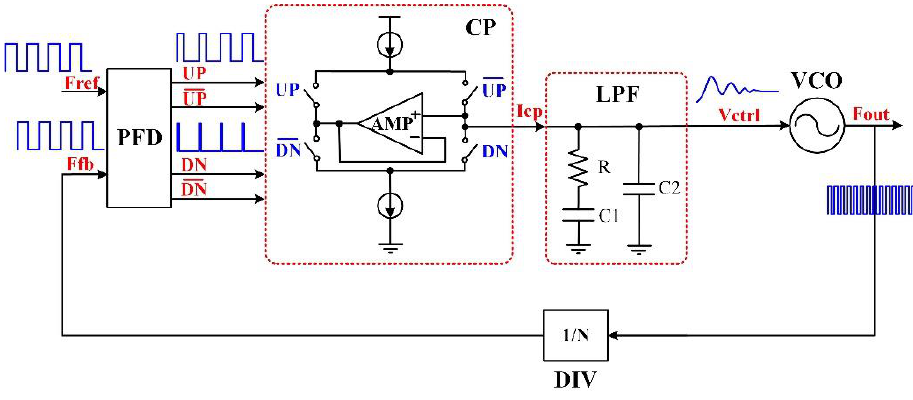
Figure 2. The topology of the CPPLL.